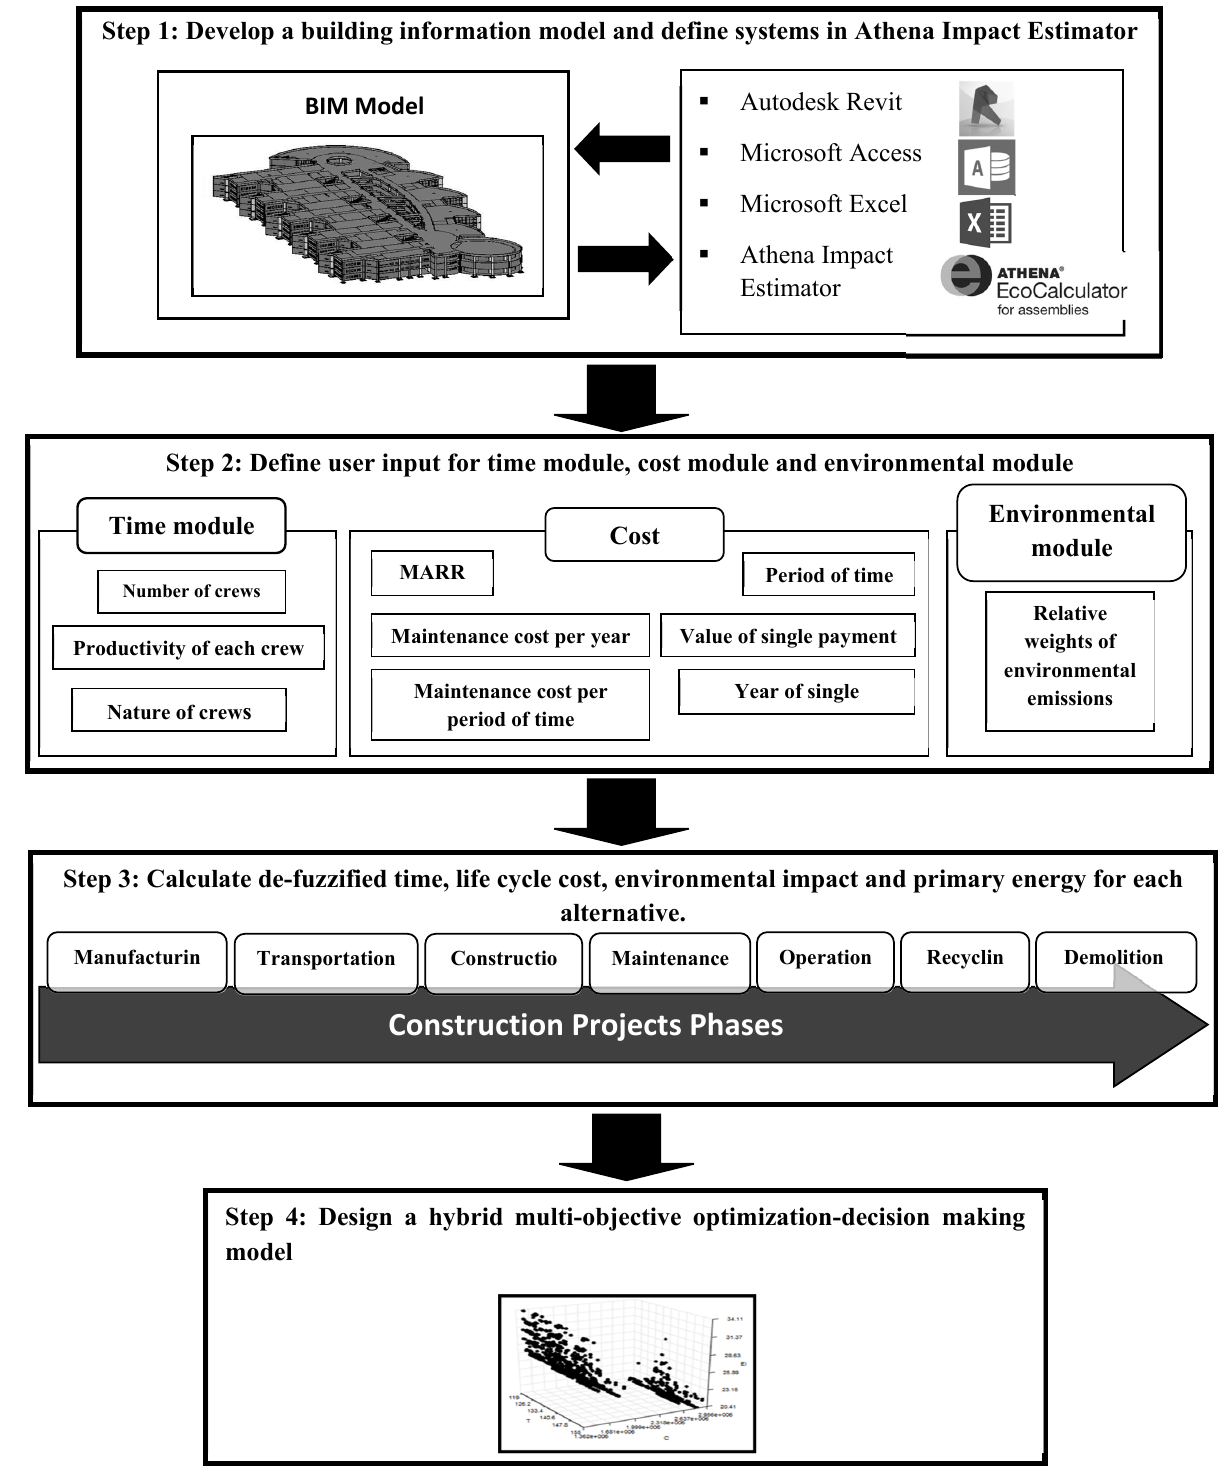
Fig. 1. Flowchart of the proposed research